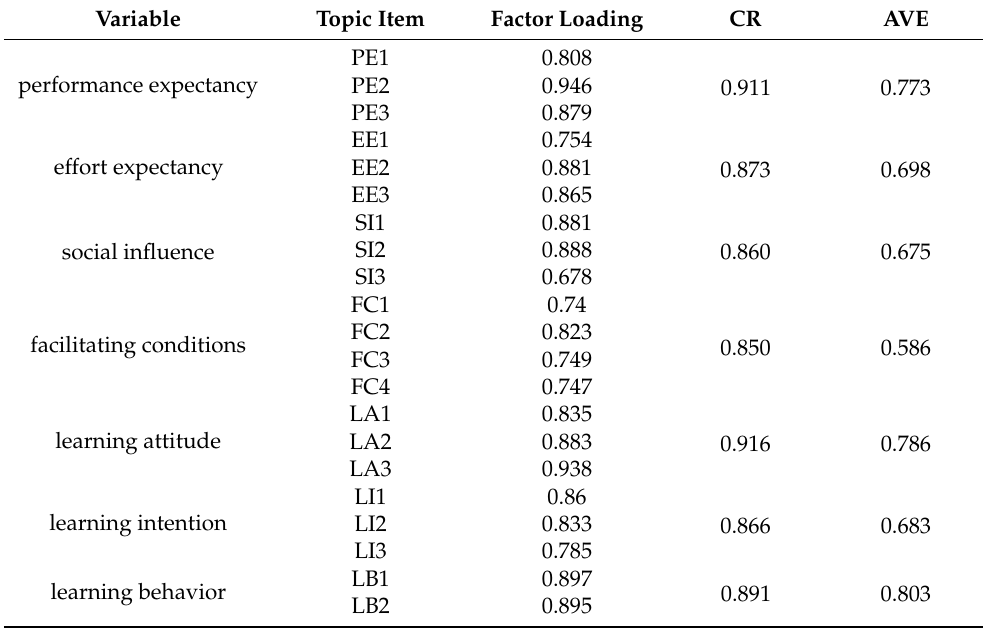
Table 4. Results table of confirmatory factor analysis.